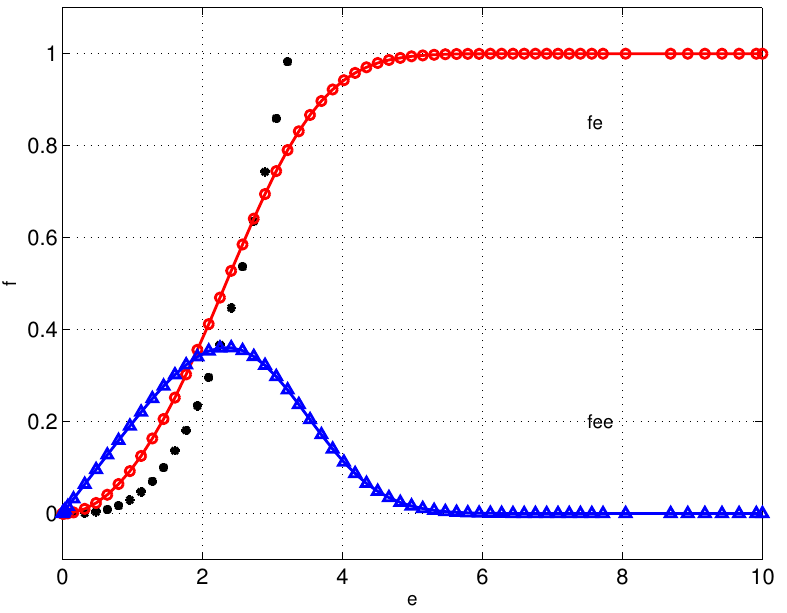
d 2 f ( 0 ) = 0 d η 2